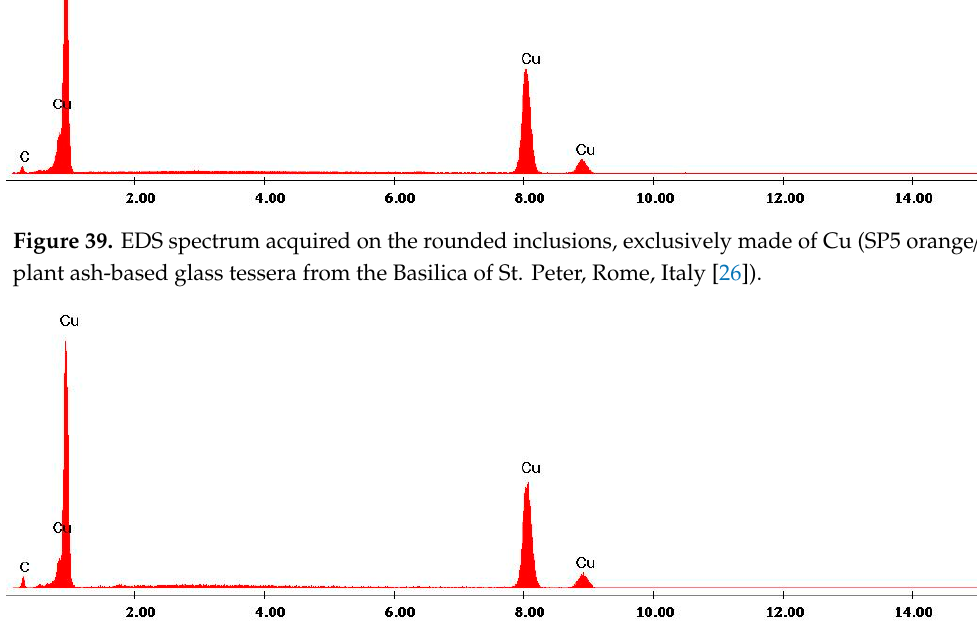
Figure 40. EDS spectrum acquired on the rounded inclusions, exclusively made of Cu (KH_R1 red natron-based Egypt I glass tessera from Khirbet al-Mafjar, Palestine [23]).